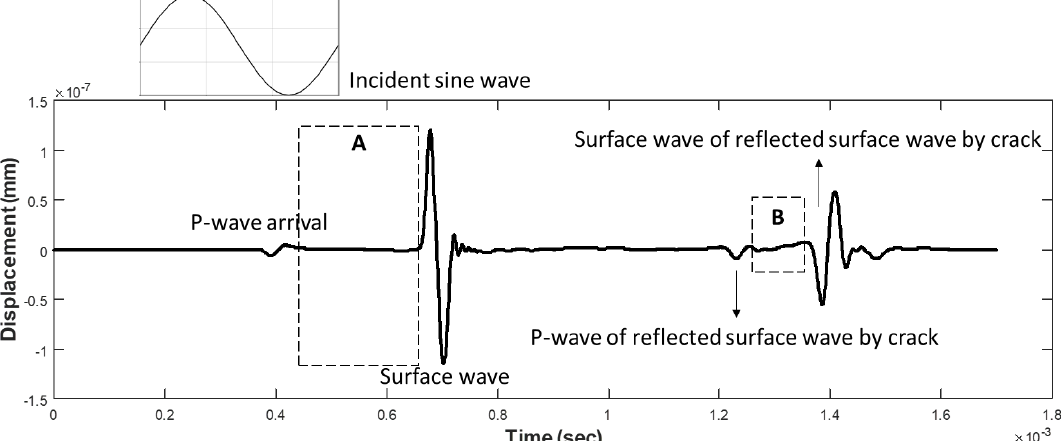
Figure 3. FE simulation results of the time-domain waveform at the node 𝑁1 in horizontal x - displacement: Waves from the incident wave and reflected waves by the crack are calculated. Both Region A and B show different arrival times as wave separations of the P-wave and surface waves. Region A is associated with the incident waves and B is associated with the reflected waves by crack. The image explains the waveform in the time-domain and the required distance of 𝐷 𝐶−𝑁1,𝑁2 and 𝐷 𝑆−𝑁1 to obtain a pure waveform of the surface waves.